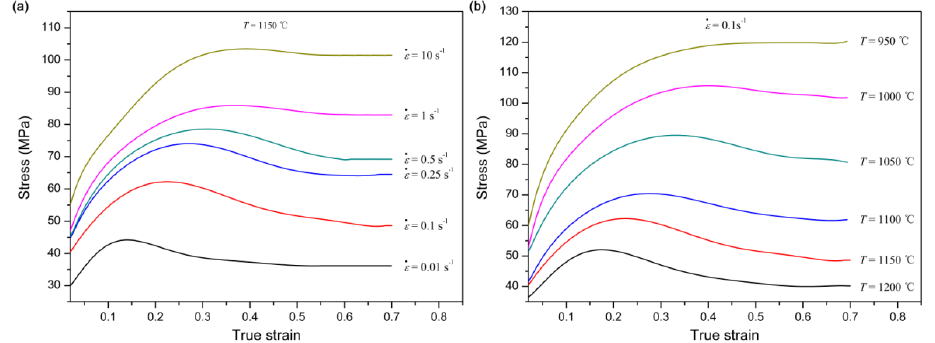
Figure 1. Typical fitted and smoothed experiment flow curves under different deformation conditions: